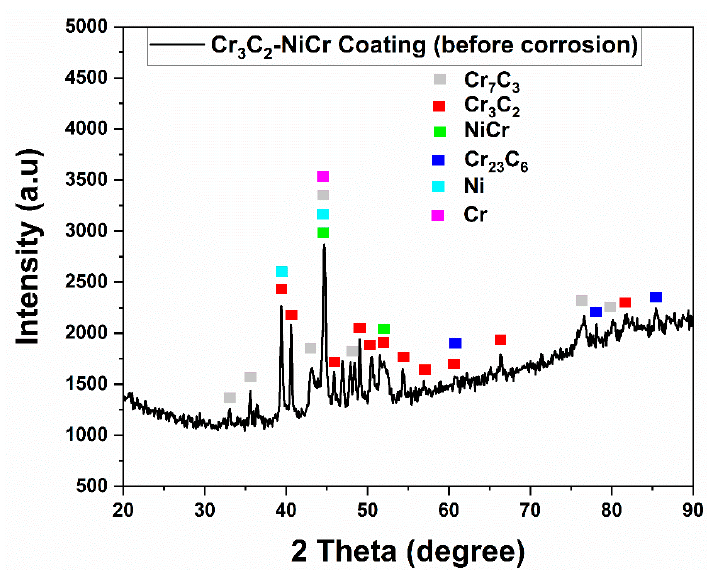
ff raction pattern of the Cr Figure 3. X ‐ ray diffraction pattern of the Cr 3 C 2 –NiCr coated sample. Figure 3. X-ray di